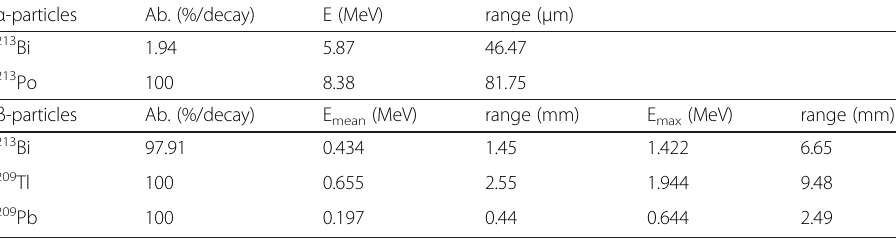
Table 1 α - and β -particle emissions by 213 Bi and its daughters, emission abundances per decay of 213 Bi or daughter nuclide and energies are from the MIRD Radionuclide data and decay schemes book (Eckerman, 2008). Particle ranges (mm) in water were determined from the NIST Star database (electrons) and with the SRIM code ( α -particles). Abundance (Ab.) is expressed in % decay and energy (E) in